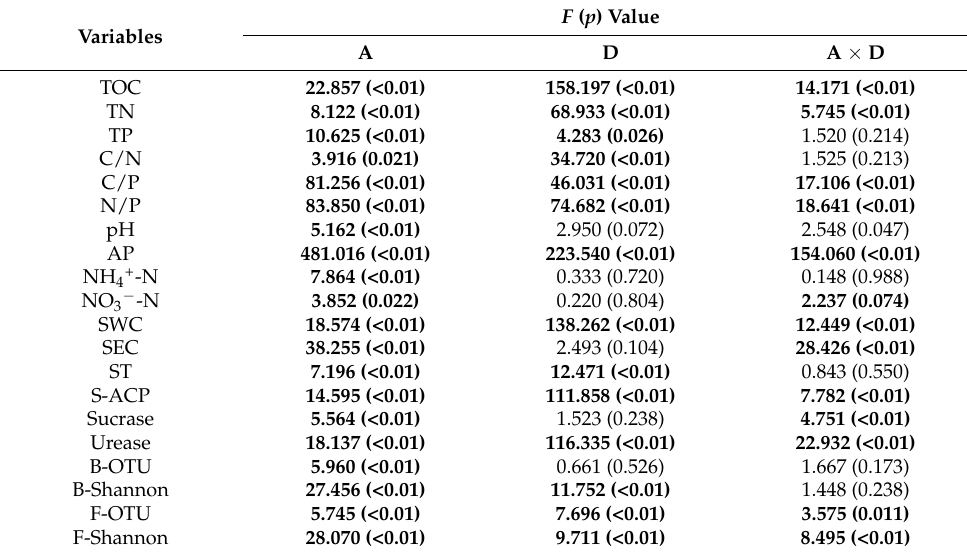
Table 2. Effects of stand age (A), soil depth (D), and their interactions on soil physicochemical properties, enzyme activities, and the microbial diversity indicated by a two-way repeated measures ANOVA. Variables